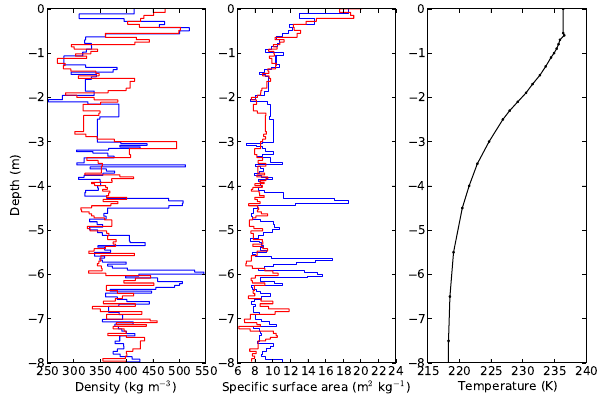
Figure 2. Density and snow-specific surface area profiles at SP1 (blue, soft snow, low brightness temperature) and SP2 (red, hard snow, high brightness temperature). Temperature profile recorded near the station.